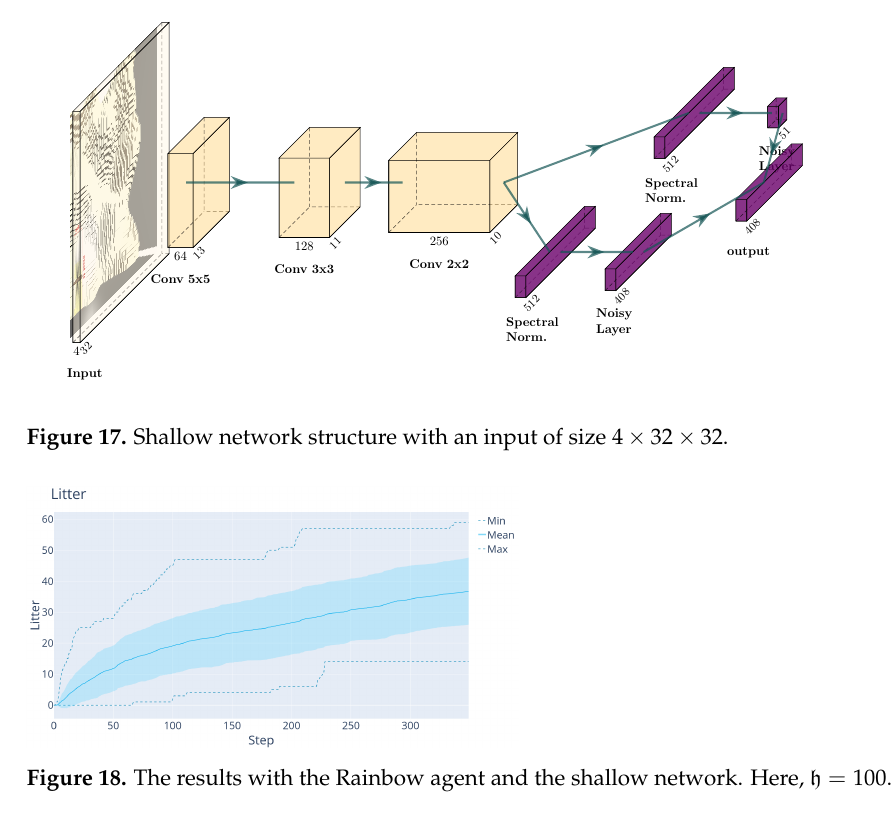
Figure 16. Network used for Rainbow.